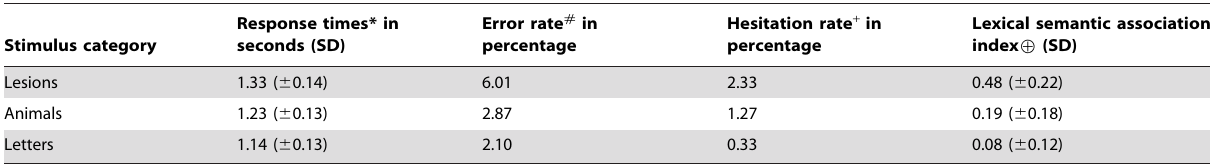
Table 1. Behavioural results.